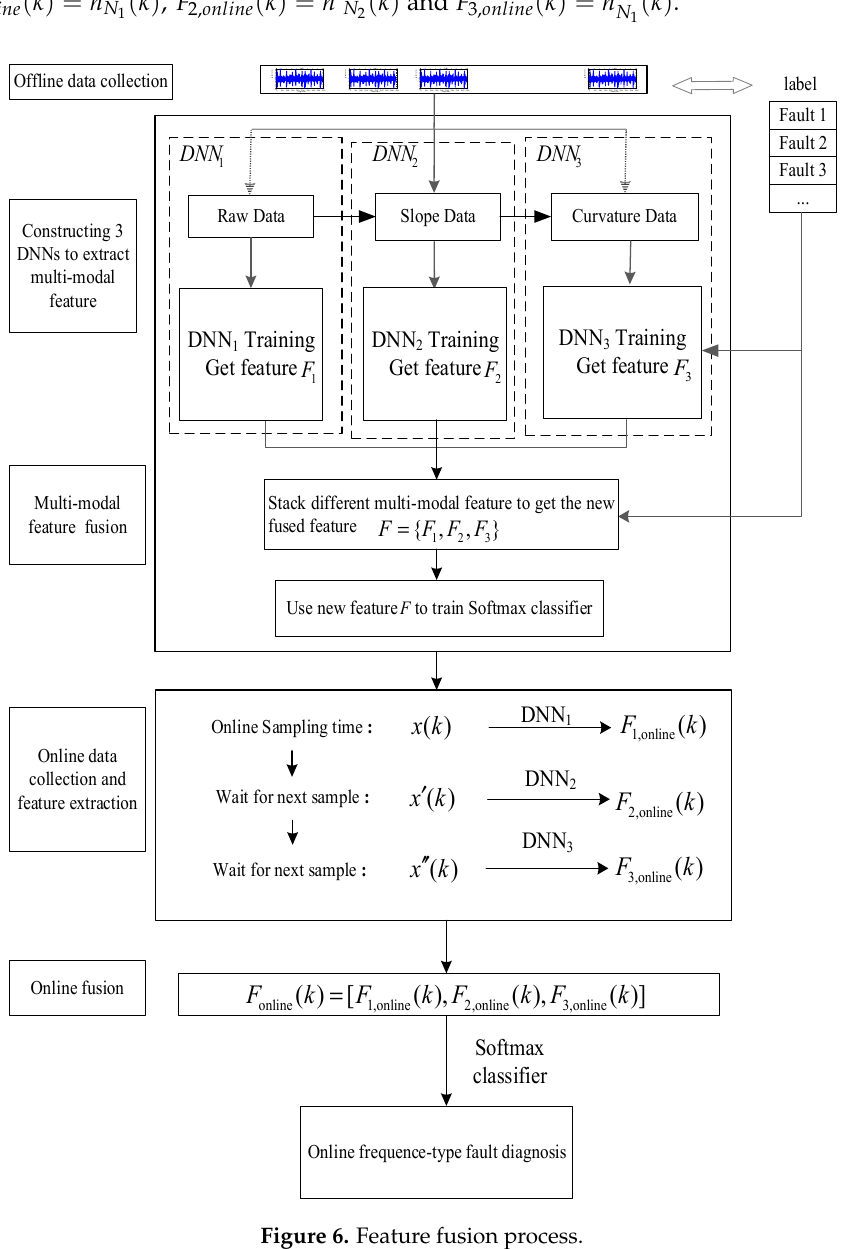
Figure 7. Schematic diagram to obtain a fused feature vector.